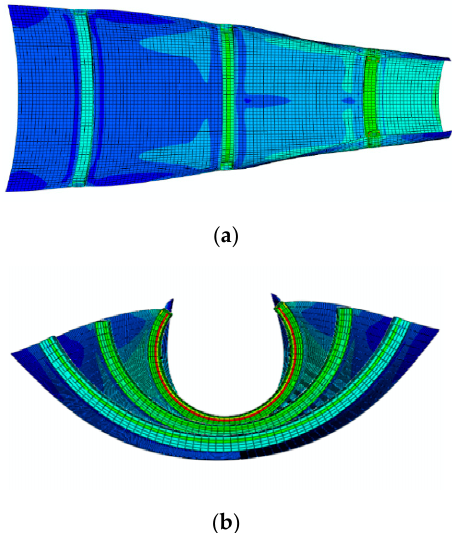
Figure 10. The FE Abaqus simulation of the self-morphing composite structure illustrated in Figure 9.